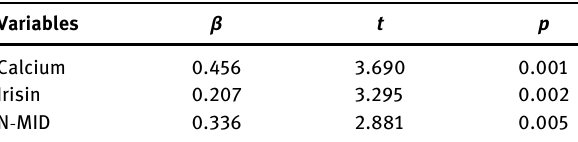
Table 3: Multiple linear regression analysis of irisin associated with other